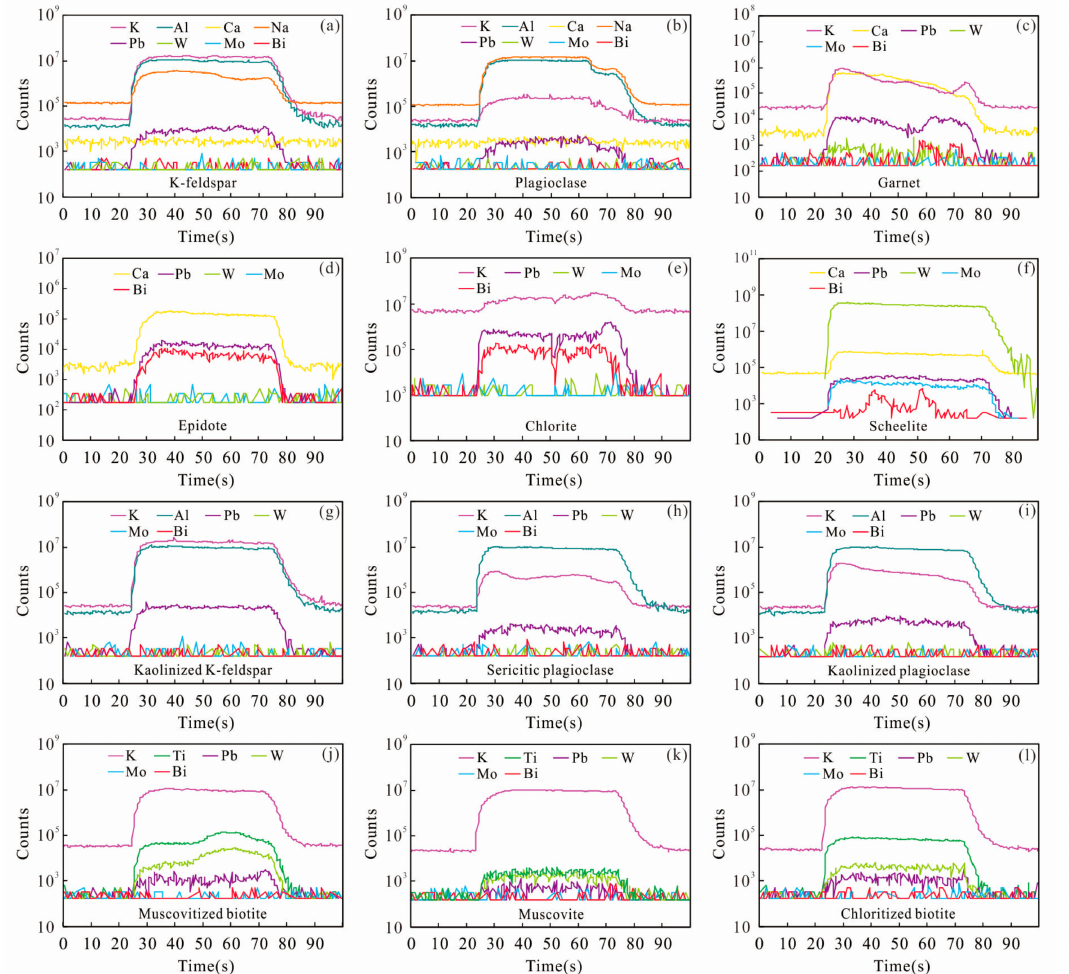
Figure 6. Representative time-resolved LA-ICP-MS depth profiles for minerals indicating the occurrences of Pb, W, Mo, Bi and other major elements. ( a ) K-feldspar (spot number 076); ( b ) Plagioclase (spot number 006); ( c ) Garnet (spot number 035); ( d ) Epidote (spot number 029); ( e ) Chlorite (spot number 025); ( f ) Scheelite (spot number 150); ( g ) Kaolinized K-feldspar (spot number 055); ( h ) Sericitic plagioclase (spot number 018); ( i ) Kaolinized plagioclase (spot number 014); ( j ) Muscovitized biotite (spot number 128); ( k ) Muscovite (spot number 010); ( l ) Chloritized biotite (spot number